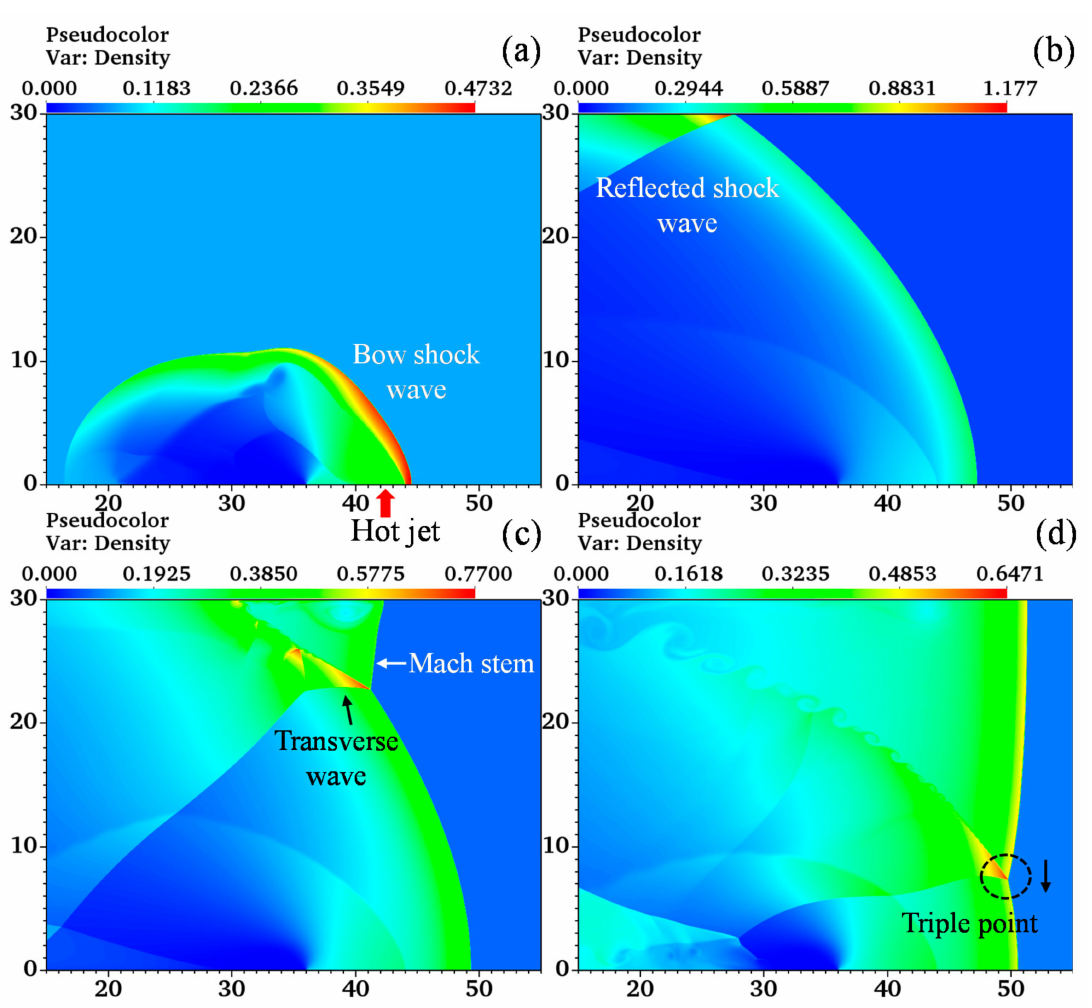
Figure 3. Density contours showing detonation initiation in straight channel, with continuous injection of a single-jet: ( a ) t = 110 µ s; ( b ) t = 130 µ s; ( c ) t = 145 µ s; ( d ) t = 170 µ